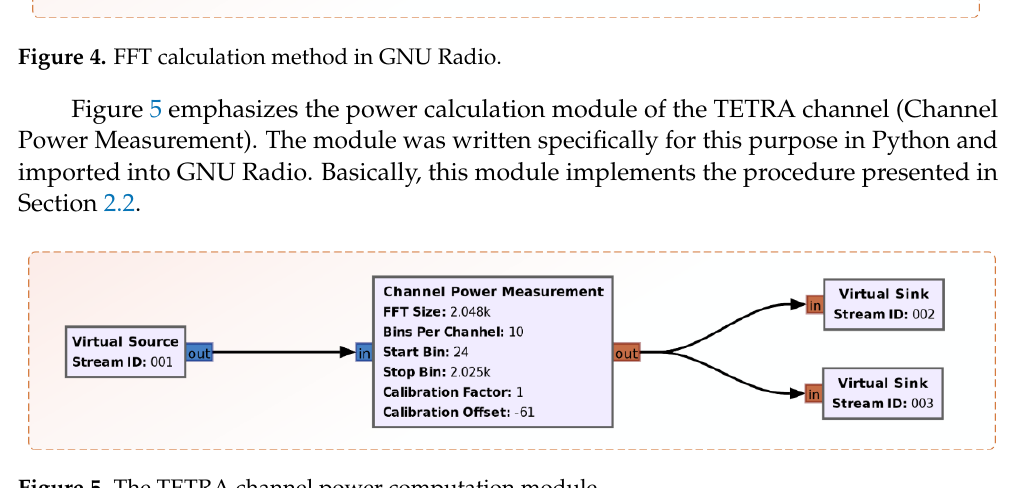
Figure 5. The TETRA channel power computation module.